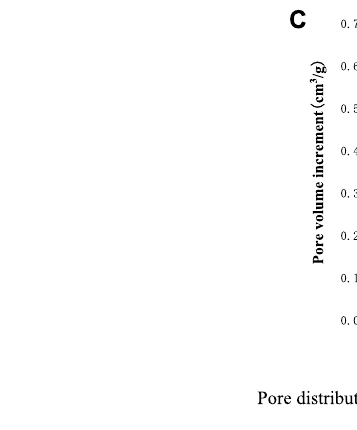
FIGURE 9 Pore distribution curves of samples during